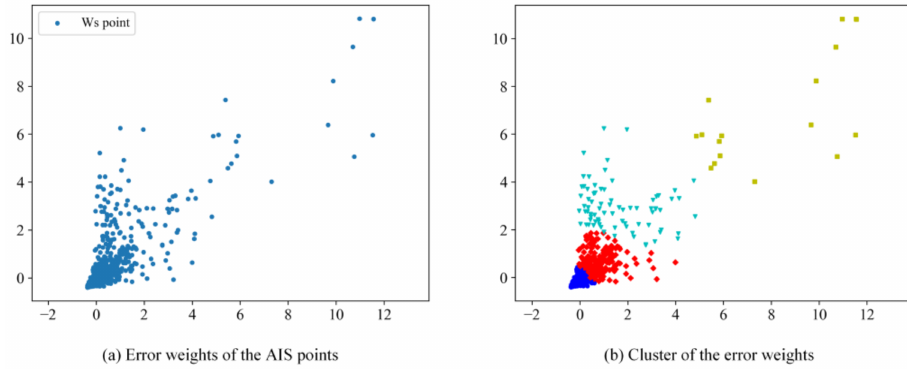
Figure 5. Example of clusters of standardization weight